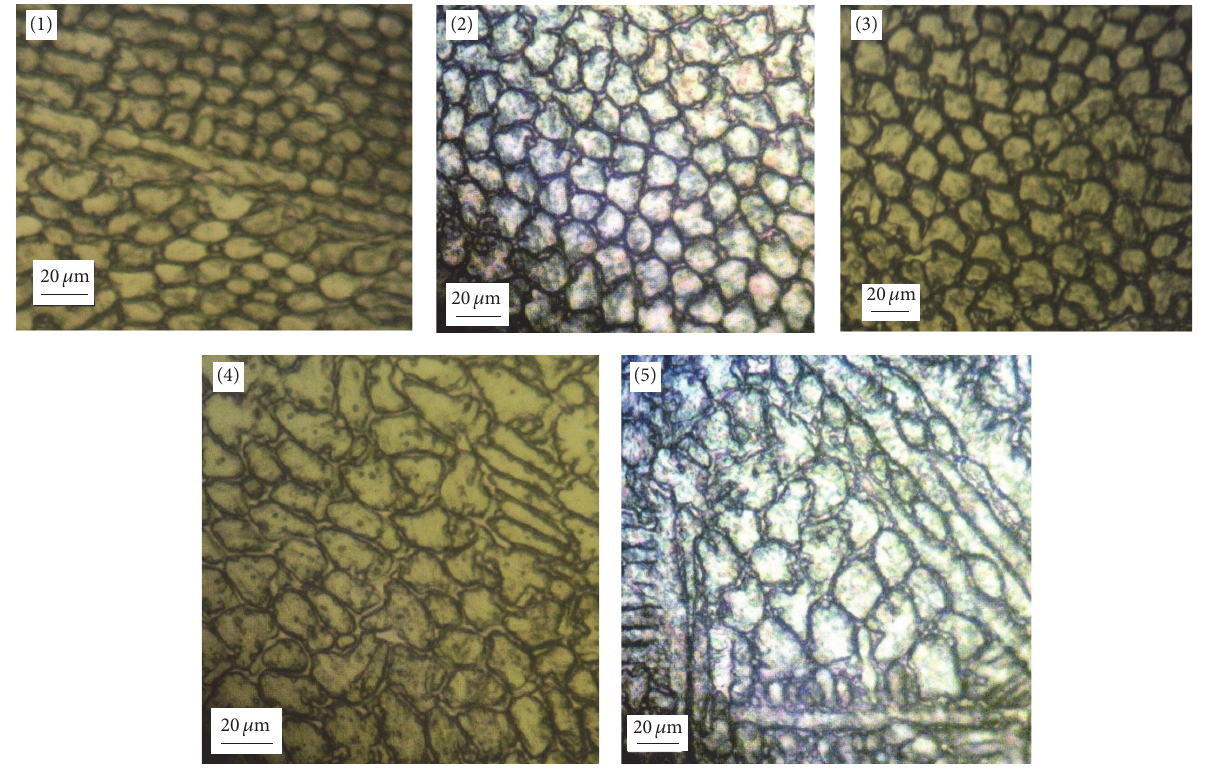
Figure 5: The grain size from welded microstructure. Table 4: The calculation based on Schaeffler diagram for prediction of welds microstructures for sample number 3. Sample location